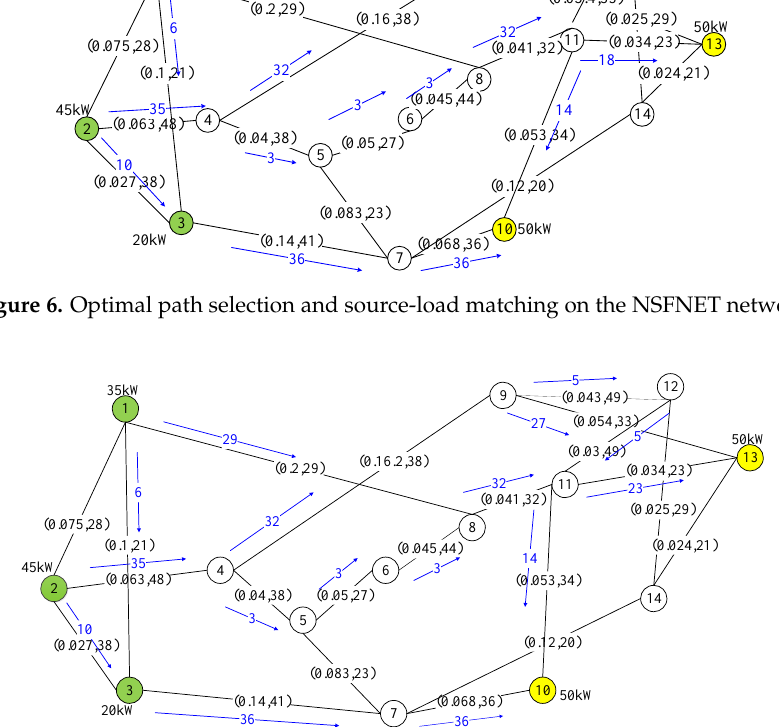
Figure 7. Path selection and source-load matching by GRASP on the NSFNET